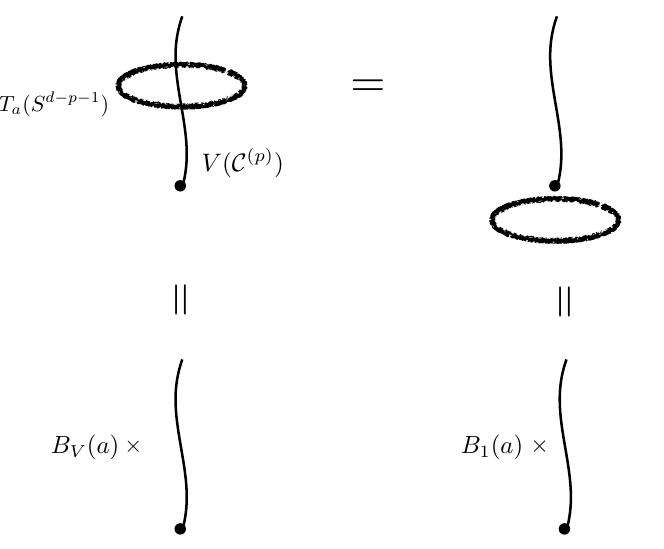
Figure 1 . Endable operators and topological operators. If a dimension p charged operator V ( C ( p ) ) can end, a topological operator T a ( S d − p − 1 ) surrounding it may be shrunk to a point, yielding a factor of B V ( a ) (left), or it may be unlinked, yielding a trivial factor B 1 ( a ) . This means that if T